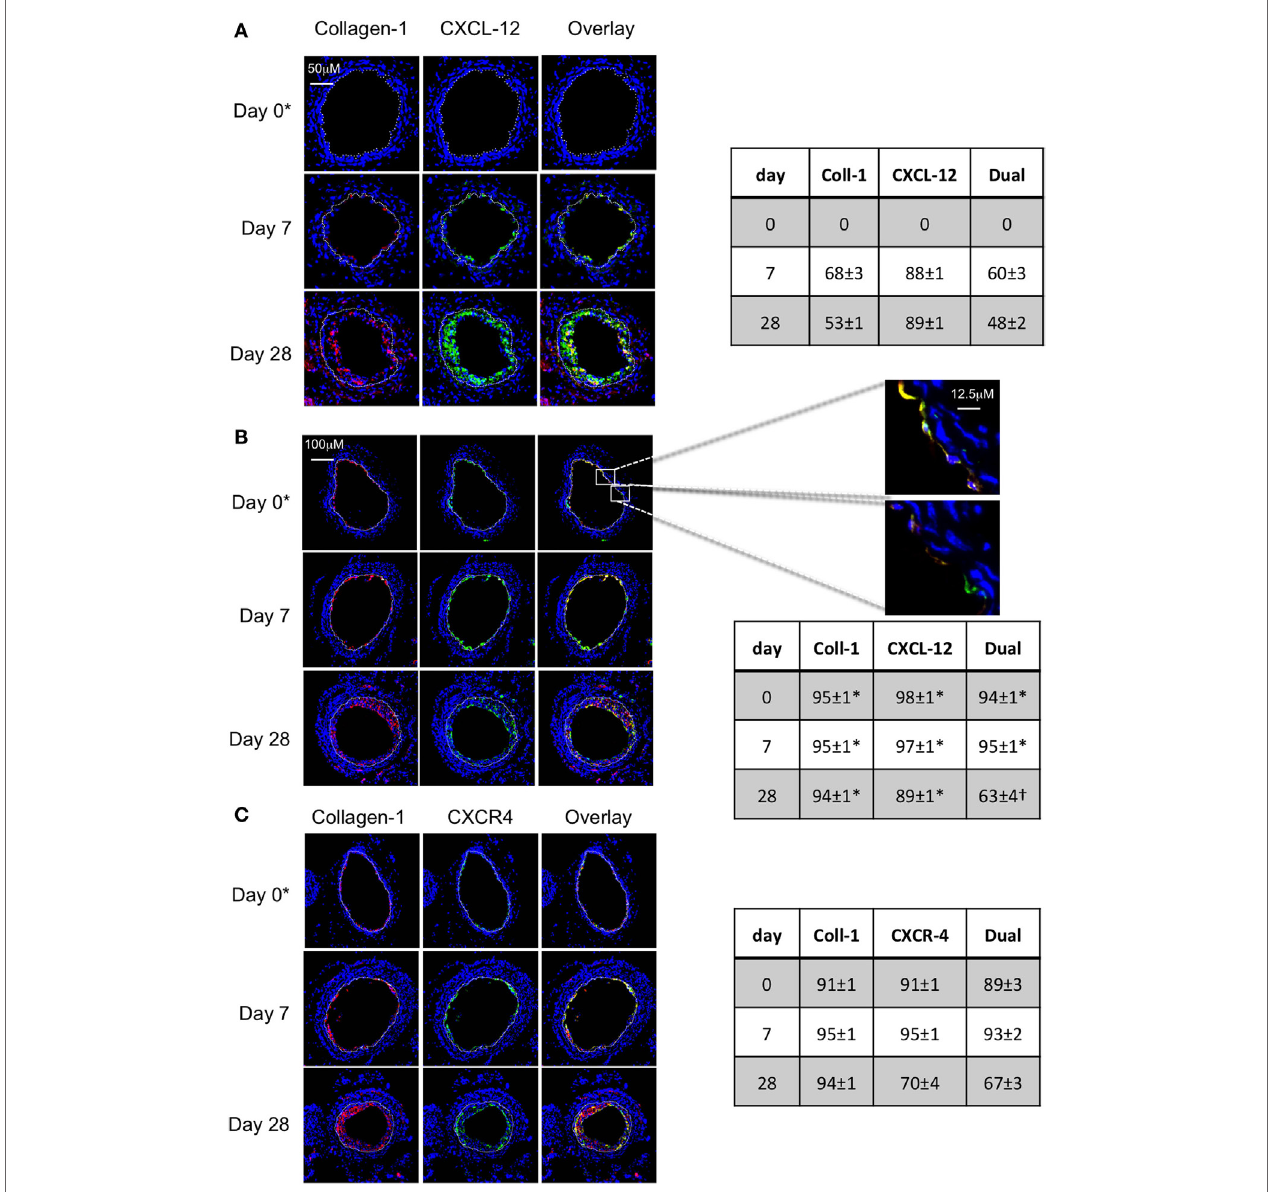
FigUre 9 | Association between CXCL-12 and intimal hyperplasia (IH). Panels show immunohistology of representative sections through injured mouse carotid arteries harvested on days post-injury as indicated. Sections from same day are consecutive. All sections stained with DAPI (4,6 diamidino-2-phenylindole) nuclear stain (blue) and (red) anti-collagen-1, and (green) anti-CXCL-12 (a,B) or CXCR4 (c) . Yellow indicates co-localization. The annotated white line defines the junction between neointima and media. (a) Injured mice that received no adoptively transferred cells. (B,c) Adoptive transfer of wild-type (WT) CD34 + cells to WT mice immediately after post-injury. *Sections harvested within an hour of injury. Expanded areas illustrate that most of the early recruited myofibrocytes are expressing CXCL-12, though there is luminal CXCL-12 that is independent of collagen-1 at early time periods. Tables beside panels describe summary of staining from all mice ( n = 6), showing the proportion of the neointimal area that is positive for collagen-1, CXCL-12 (a,B) , or CXCR4 (c) or dual positive on days 0, 7, and 28 (% ± SEM). Data derived from three random sections from each of the arteries from each mouse (see Materials and Methods). *cf no adoptive transfer (a) at equivalent time p < 0.001. † cf no adoptive transfer (a) at equivalent time p = 0.02. Experiments repeated at least